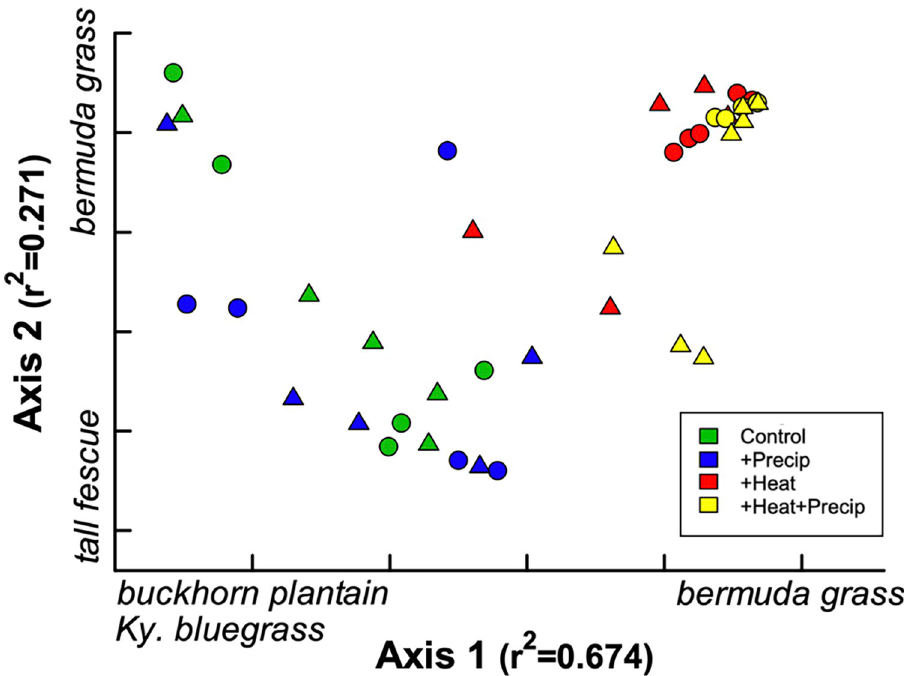
Fig 5. Ordination of plant species cover in the slug exclosures (triangles) and control rings (circles) from each climate treatment plot. The plant species noted at each end of the axes indicate the positive and negative drivers of the ordinations and had an R-value � 0.65.